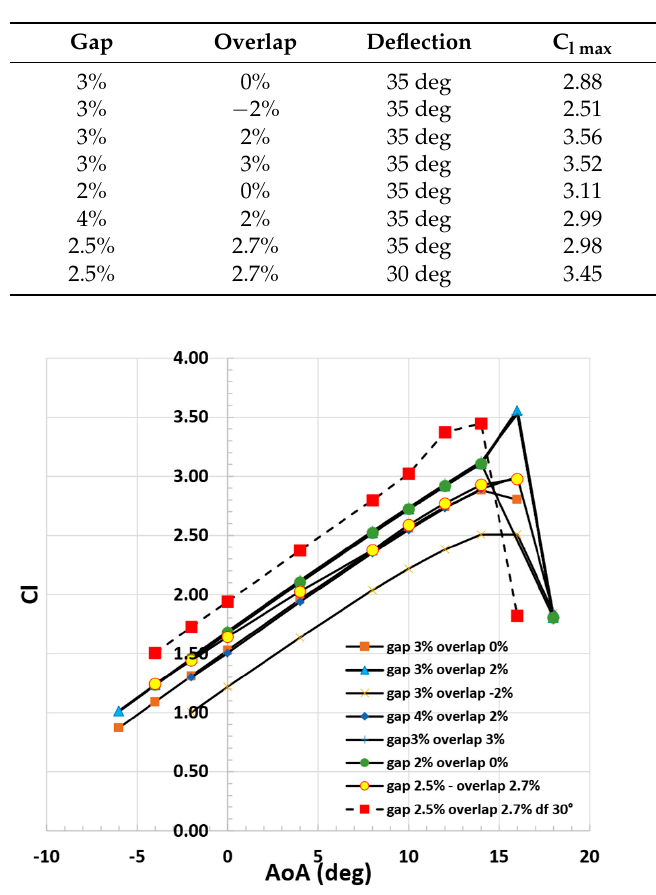
Figure 15. Numerical results in terms of lift coefficient curves of 2D analysis at different flap positions, landing condition, M = 0.15, Re = 5.7 × 10 6 .